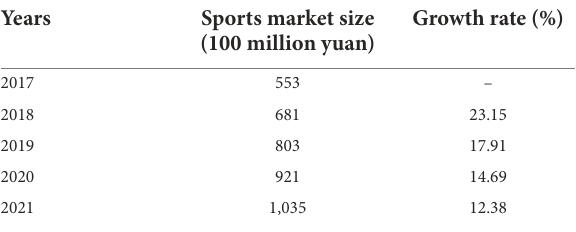
TABLE 2 The scale of the sports industry in Province A in the past 5 years. Years